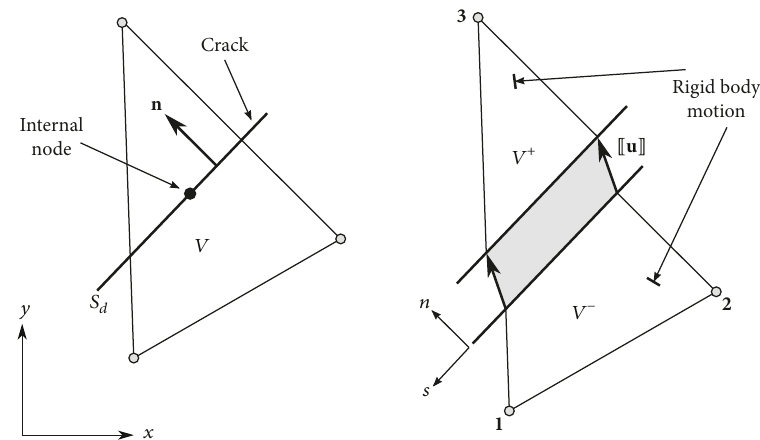
where ⟦𝑢⟧ eq is an equivalent jump obtained from the dis- placement jump vector ⟦ u ⟧ . The symbol ⟨⋅⟩ represents the Macauley brackets, denoting that only the positive part of the normal displacement jump is considered, and 𝜅 is a scalar internal variable, equal to the largest value of ⟨⟦𝑢⟧ eq ⟩ ,